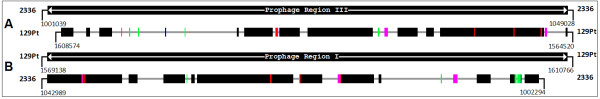
(A) BLASTN of prophage region III of strain 2336 (47,990 bp) against the chromosome of strain 129Pt and (B) BLASTN of prophage region I of strain 129Pt (41,629 bp) against the chromosome of strain 2336. The numbers below each of the maps refer to the nucleotide positions in the respective chromosomes. The matches are color-coded according to the BLASTN alignment scores (Red < 40, Blue = 40-50, Green = 50-80, Pink = 80-200, and Black ≥ 200; a gray line indicates the absence of a significant match).